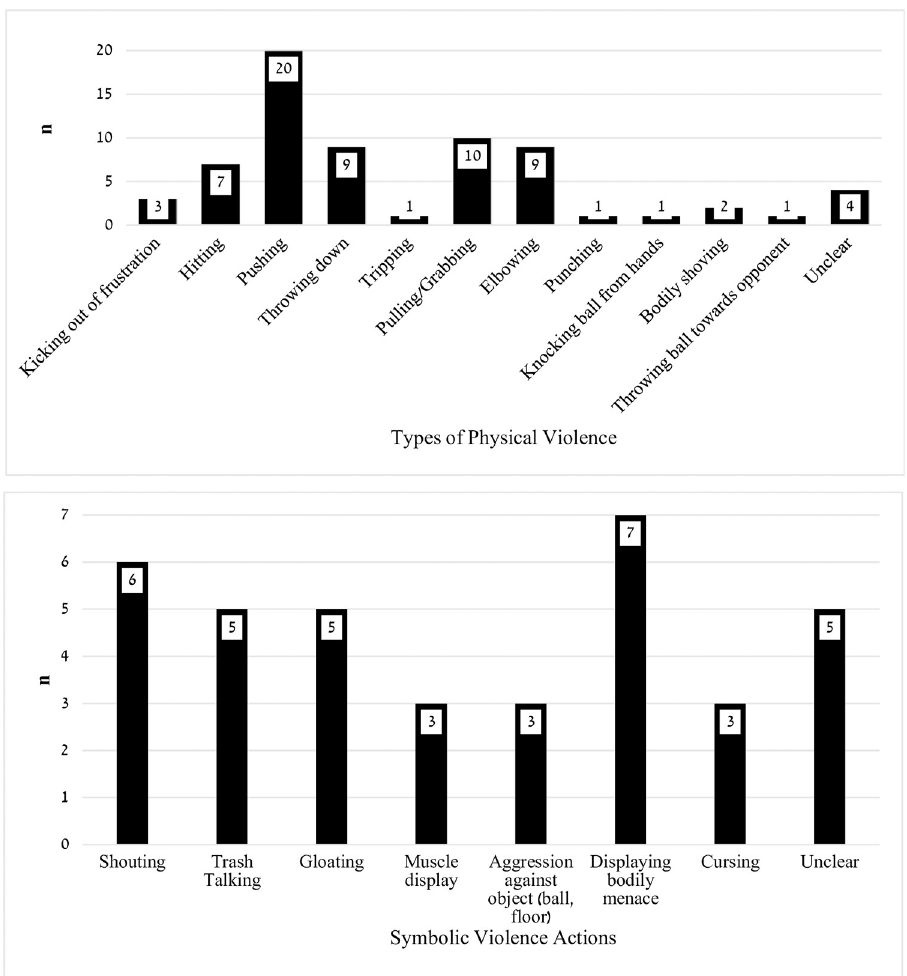
Fig 1. Distribution of physical (upper panel) and symbolic (bottom panel) violent acts in 36 NBA games.